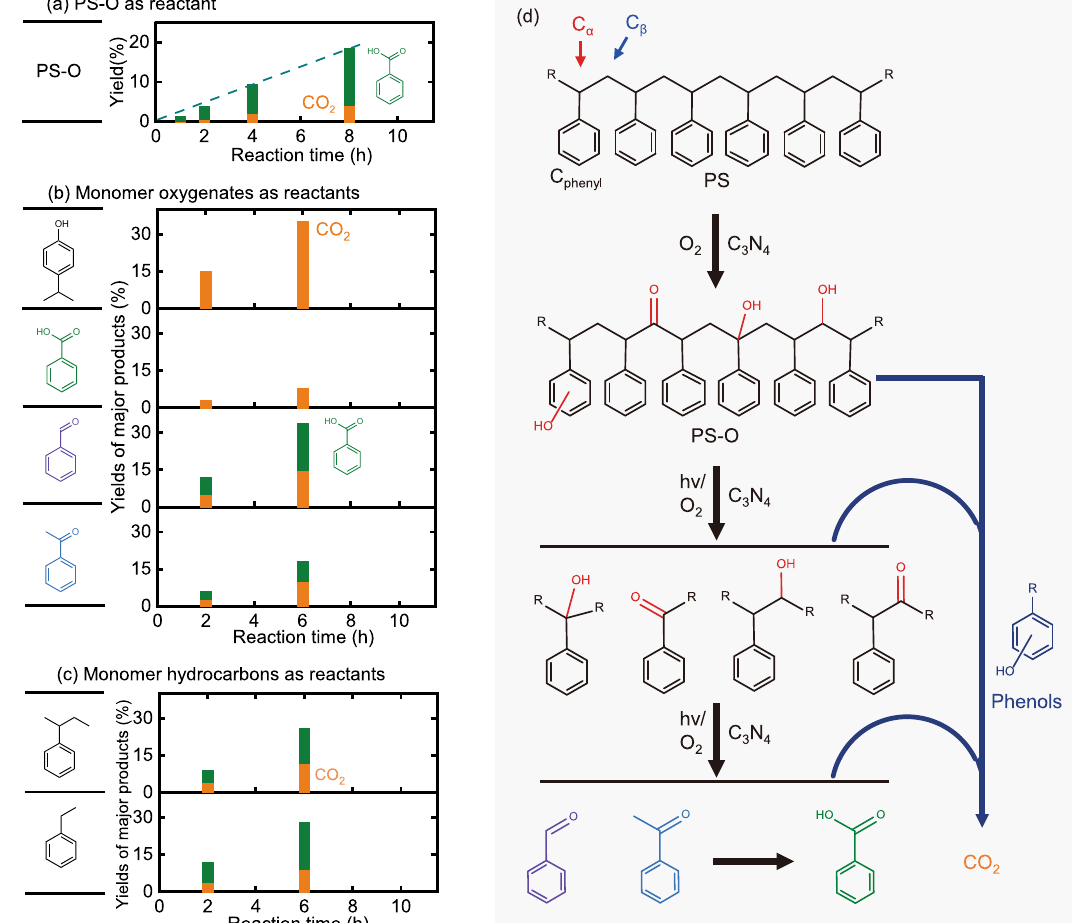
Fig. 2 | Reaction performances of different model molecules and proposed reactionmechanism.a – c Catalyticperformancesof a oxygentreatedpolystyrene, ( b ) oxygenate monomers, and c hydrocarbon monomers as reactants under stan- dard reaction conditions. Reaction conditions: 50mg g-C 3 N 4 , 20mg reactant,